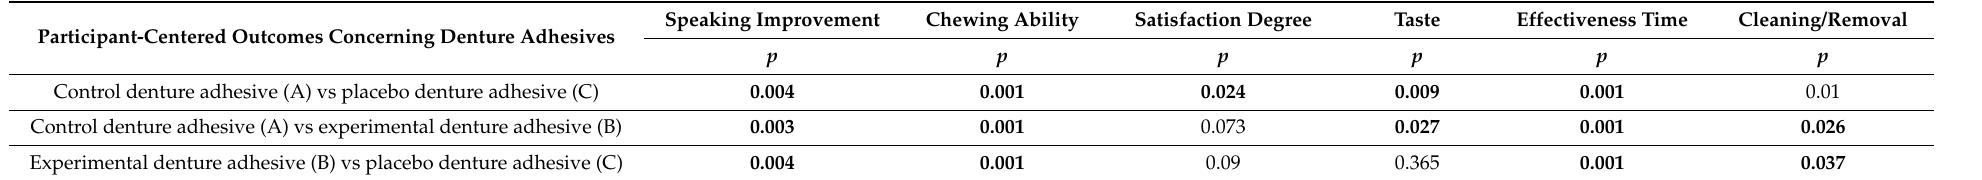
Table 2. Inferential analysis of the patient-centered